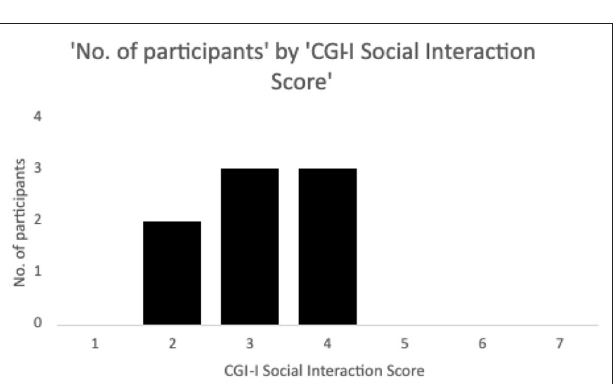
FIGURE 2 | Number of participants by Clinical Global Impressions – Improvement (CGI-I) social interaction scores following 12 weeks of memantine treatment. Ratings on the scale range from 1 to 7, with 4 being no change, and decreasing scores representing minimal (3), marked (2) and dramatic (1) improvement, and increasing scores similarly representing worsening. Patients with scores 1–3 on the social interaction subscale were classified as responders while scores of 4–7 were considered non-responders. Two additional participants who discontinued the drug due to